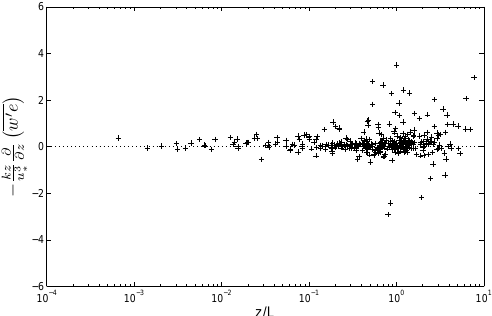
Fig. 6. Normalized turbulent transport term in the TKE budget Fig. 5. Normalized turbulent transport term in the TKE budget equation